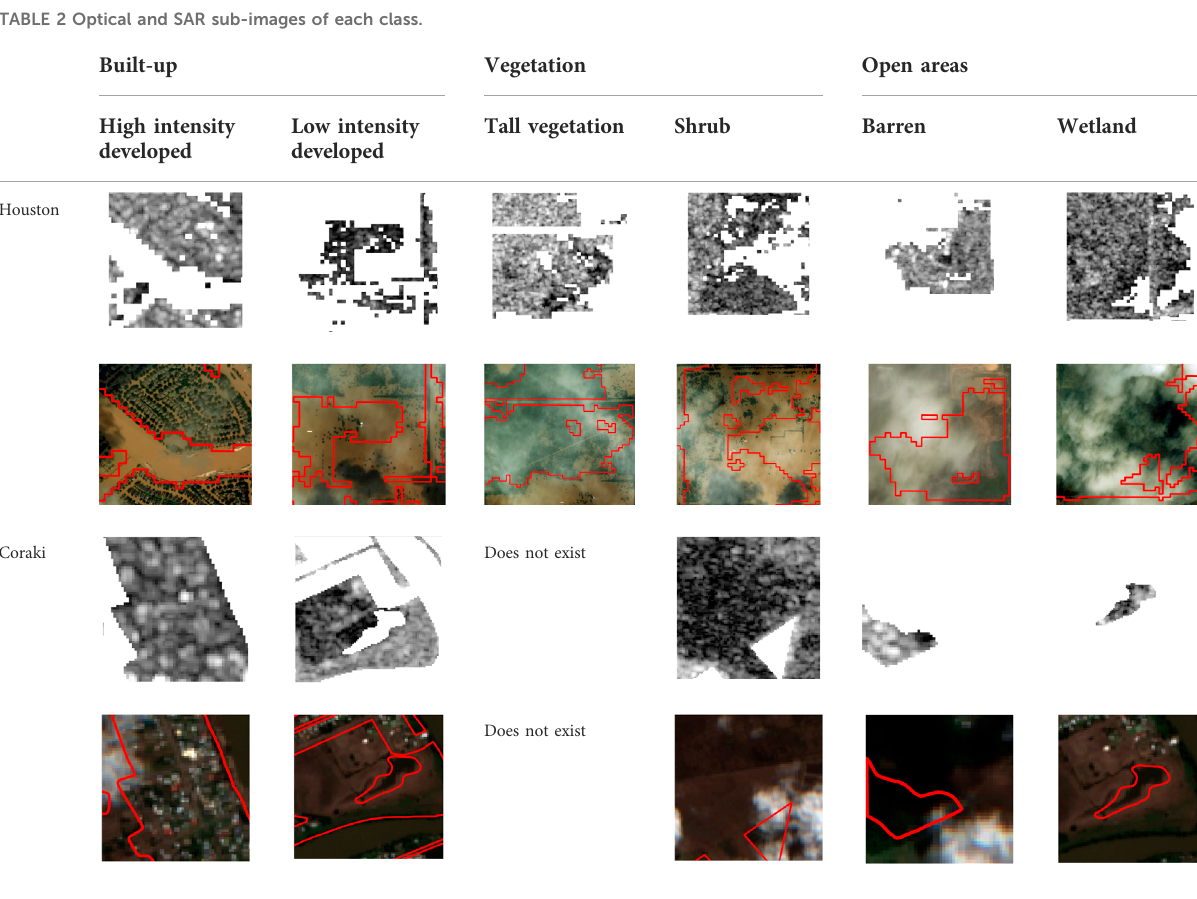
TABLE 2 Optical and SAR sub-images of each